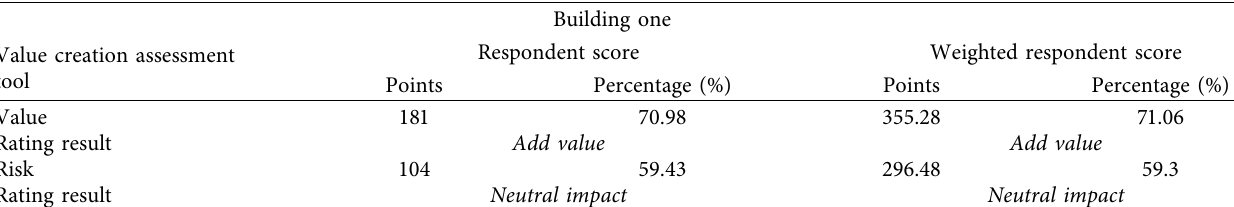
Figure 2: Results of an assessment tool for Building 1, (a) value clusters (subcriteria) plots, (b) value groups (value creation drivers) plot, and (c) risk groups plot. Table 4: Building one fnal rating